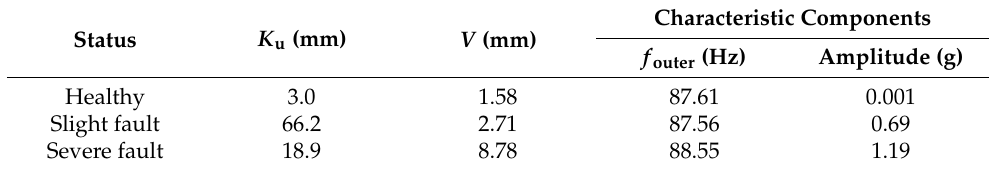
Characteristic Components